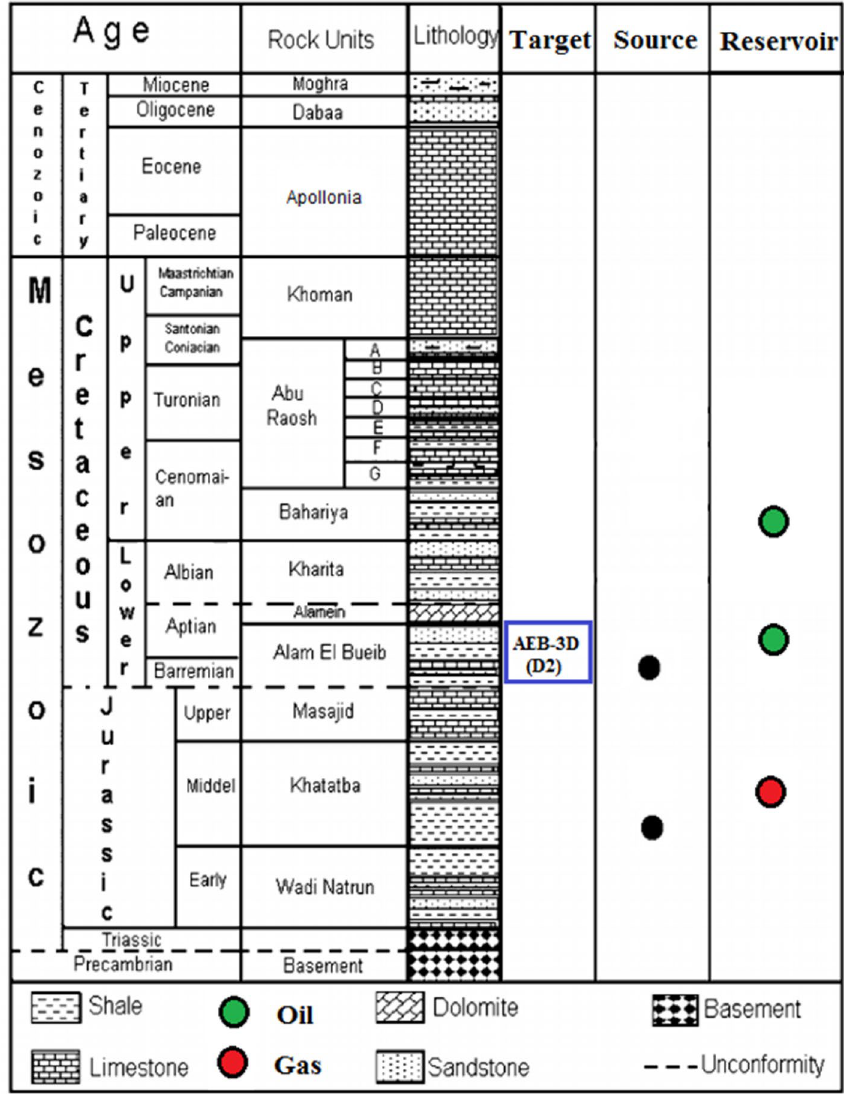
Fig. 3 Generalized stratigraphic column of Qasr field (modified after WEC 1984, 1995; EGPC